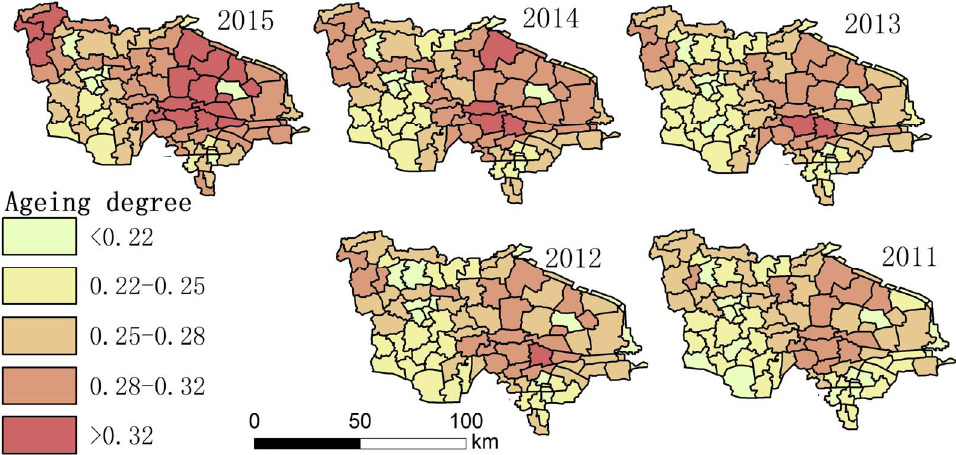
Figure 2. The proportion of the total population over 60 in each town.